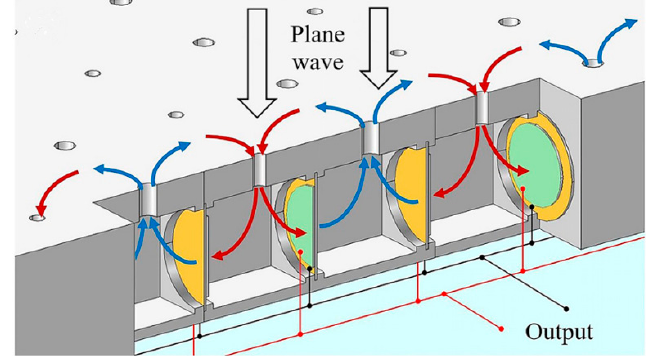
Figure 26. Schematic diagram of the AEH metasurface Reproduced with permission from [69]; published by American Institute of Physics, 2018.